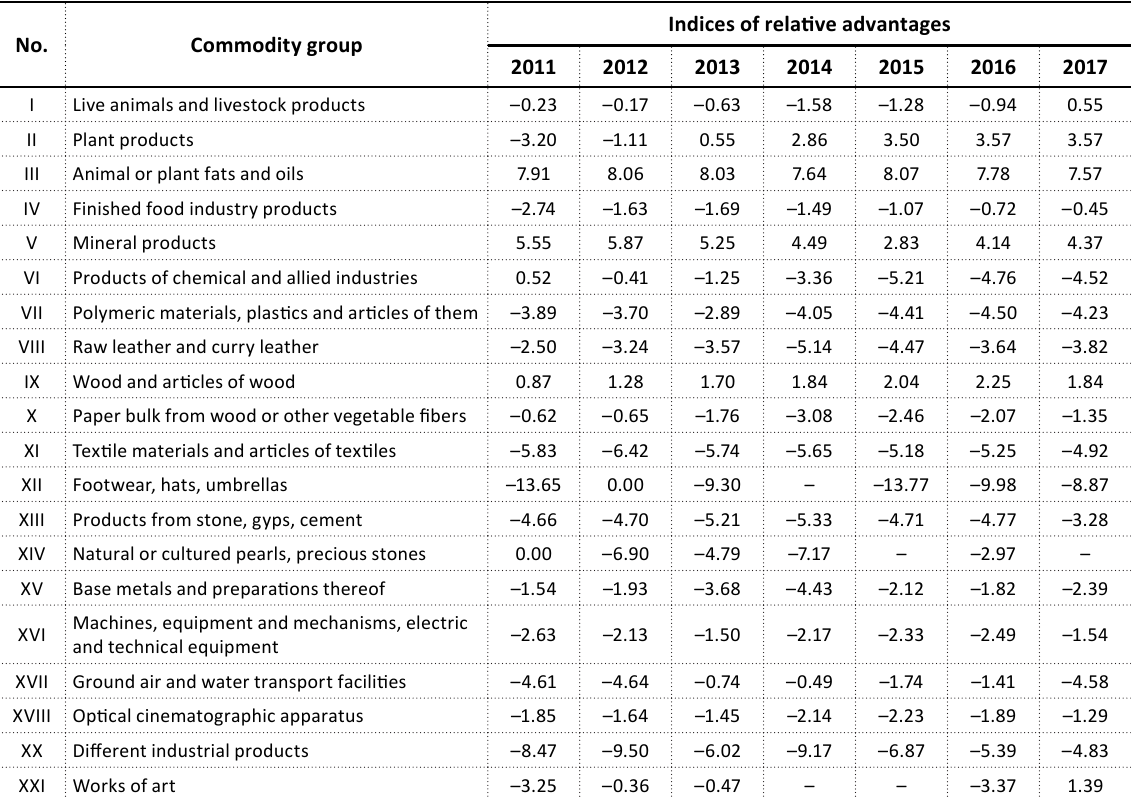
Table 2. Indices of relative advantages in the mutual trade between Ukraine and China by product groups in